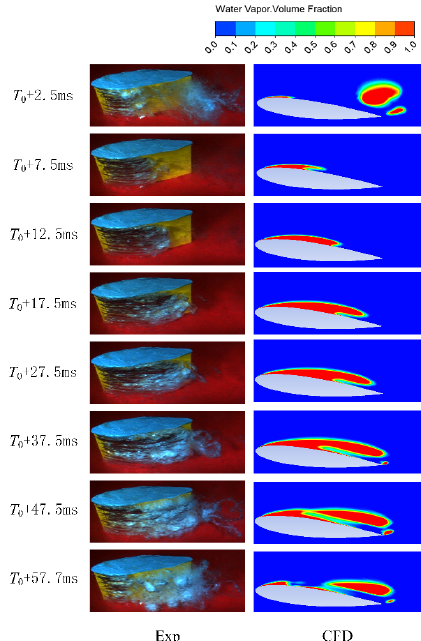
Figure 13. Numerical results and experimental data. Appl. Sci. 2019 , 9 , x FOR PEER REVIEW